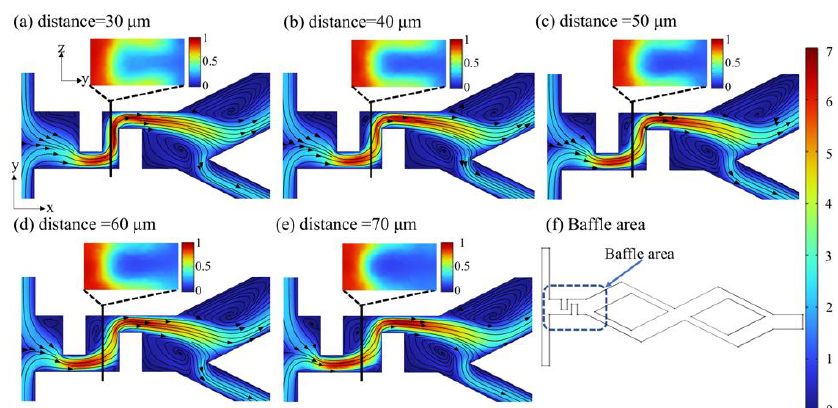
Figure 21. Velocity distribution (m/s) in baffle area and concentration distribution in baffle middle section at Re = 60. ( a ) distance = 30 µ m; ( b ) distance = 40 µ m; ( c ) distance = 50 µ m; ( d ) distance = 60 µ m; ( e ) distance = 70 µ m; ( f ) Baffle area